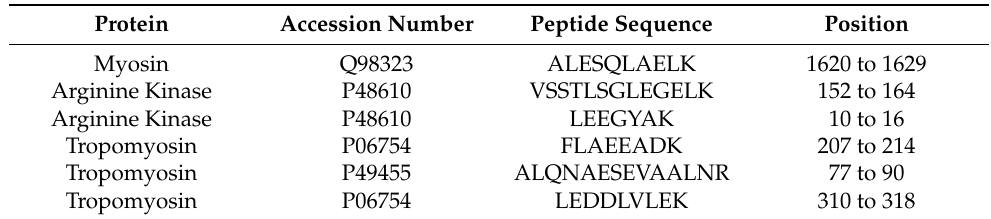
Table 6. Unique proteins and accession numbers identified in black solider fly larvae to be used to differentiate between black soldier fly larvae and crustaceans.